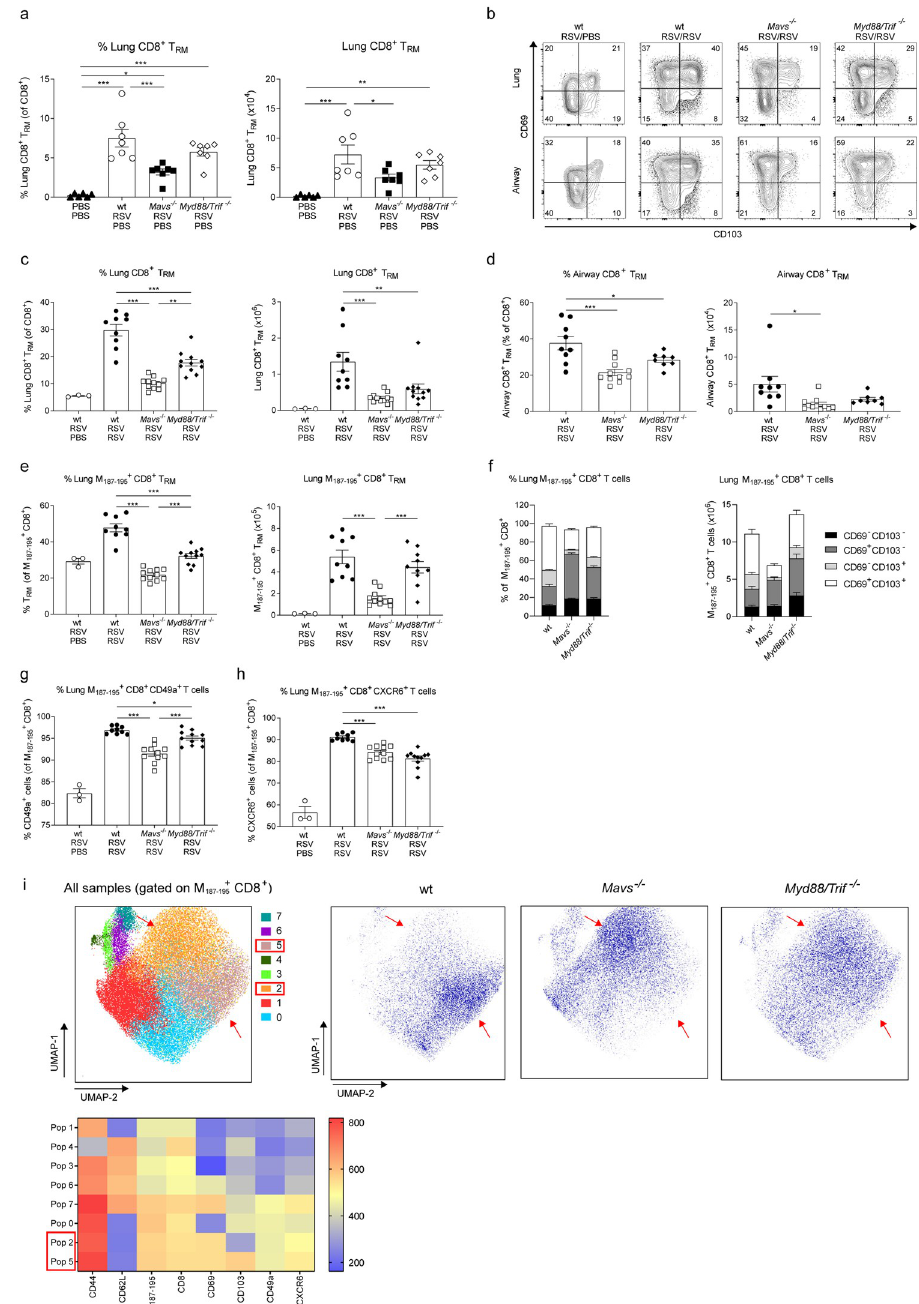
Fig 4. PRR signaling is required for T RM cell expansion during RSV secondary challenge. Wt, MAVS ( Mavs -/- ) and MyD88/TRIF deficient ( Myd88/Trif -/- ) mice were infected with RSV and 25 days later lung cells were recovered and compared with mock infected (PBS/PBS) wt mice. Percentage and numbers of CD8 + T RM were analyzed by flow cytometry ( a ). Data are represented as mean ± SEM of 7 mice per group pooled from two independent experiments. Wt, Mavs -/- and Myd88/Trif -/- mice were infected with RSV and three weeks later re-infected with RSV. Four days after re-infection mice were euthanized and airway and lung cells were recovered and the CD8 + T RM cell populations analyzed. ( b ) Representative flow cytometry plots showing CD69 and CD103 expression on lung and airway CD8 + T EF cells. Percentage of CD103 + CD69 + T RM cells in CD8 + T EF cells and total number of ( c ) lung and ( d ) airway CD69 + CD103 + T RM cells in wt, Mavs -/- and Myd88/Trif -/- re-infected mice. Lung cells were stained with RSV M 187-195 containing tetramers to identify RSV-specific CD8 + T cells. ( e ) Percentage of M 187-195 specific CD69 + CD103 + T RM cells of M 187-195 specific CD8 + T cells and total number of M 187-195 specific CD69 + CD103 + T RM cells. ( f ) Stacked